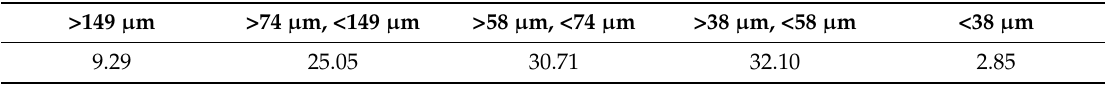
Table 3. Particle size distribution of the sample of magnetic tailing